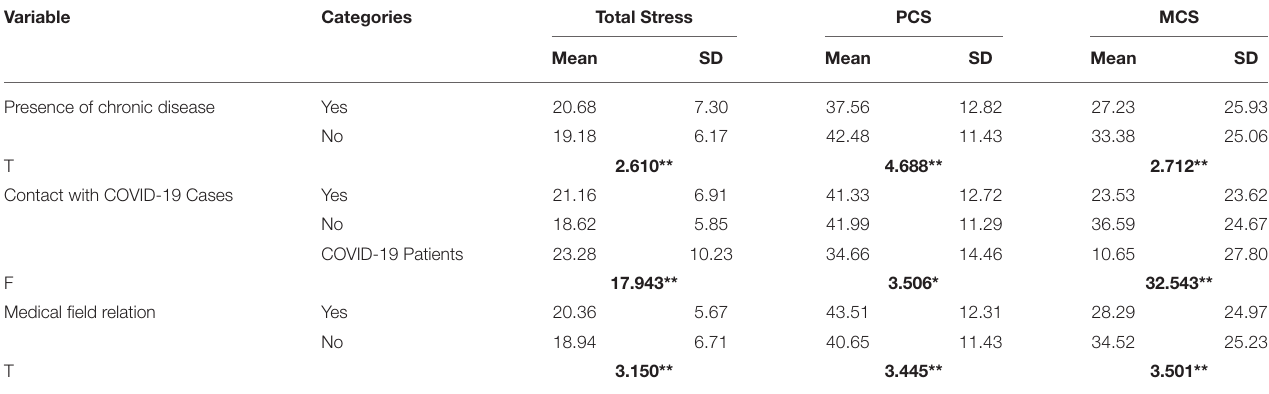
TABLE 7 | Mean and difference among COVID-19 total stress, PCS, MCS, relation with the medical field, and COVID-19 cases among the study participants ( N = 878). Variable Categories Total Stress